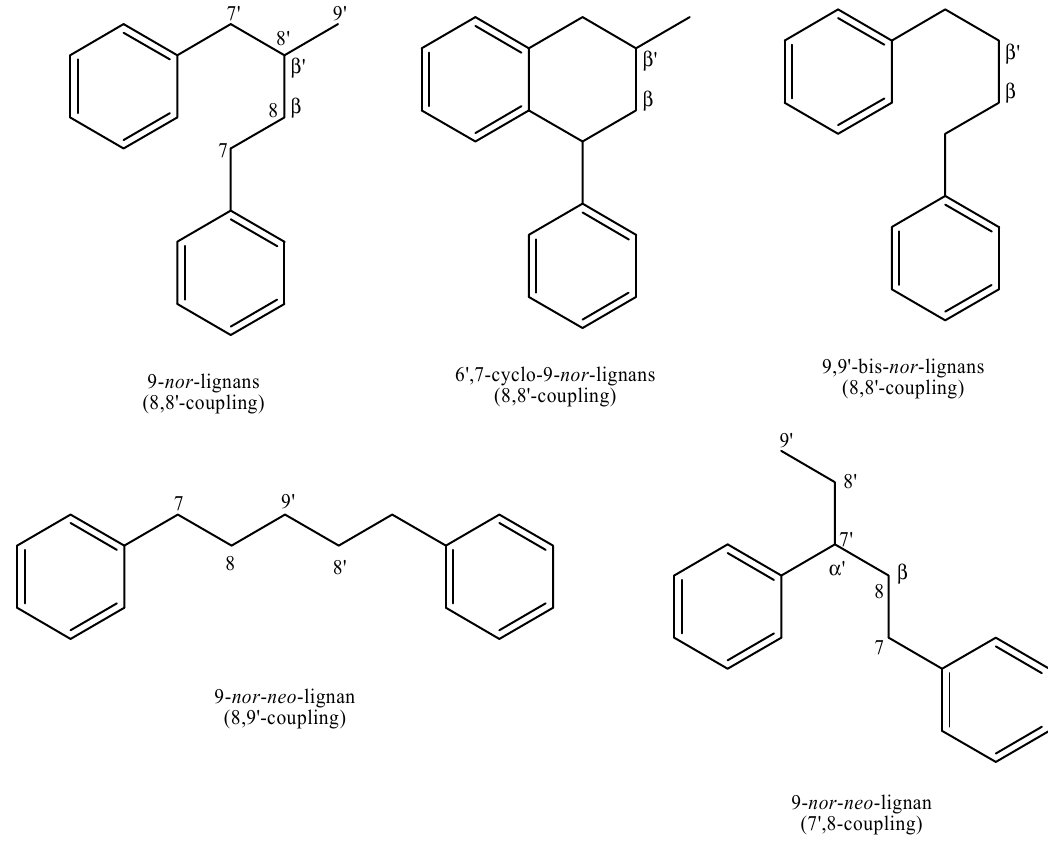
Figure 1. general nor -lignan basic structures.